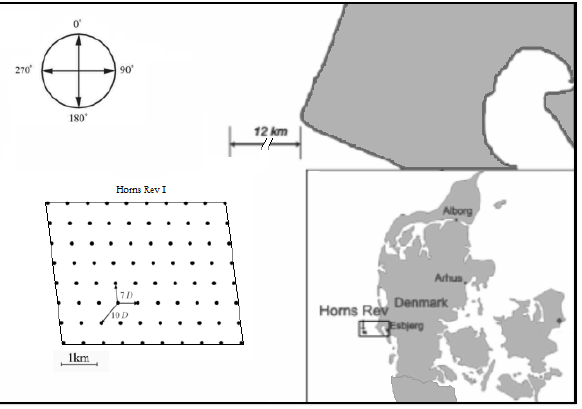
Figure 3. Baseline layout of Horns Rev I and its location with respect to the Danish coast.